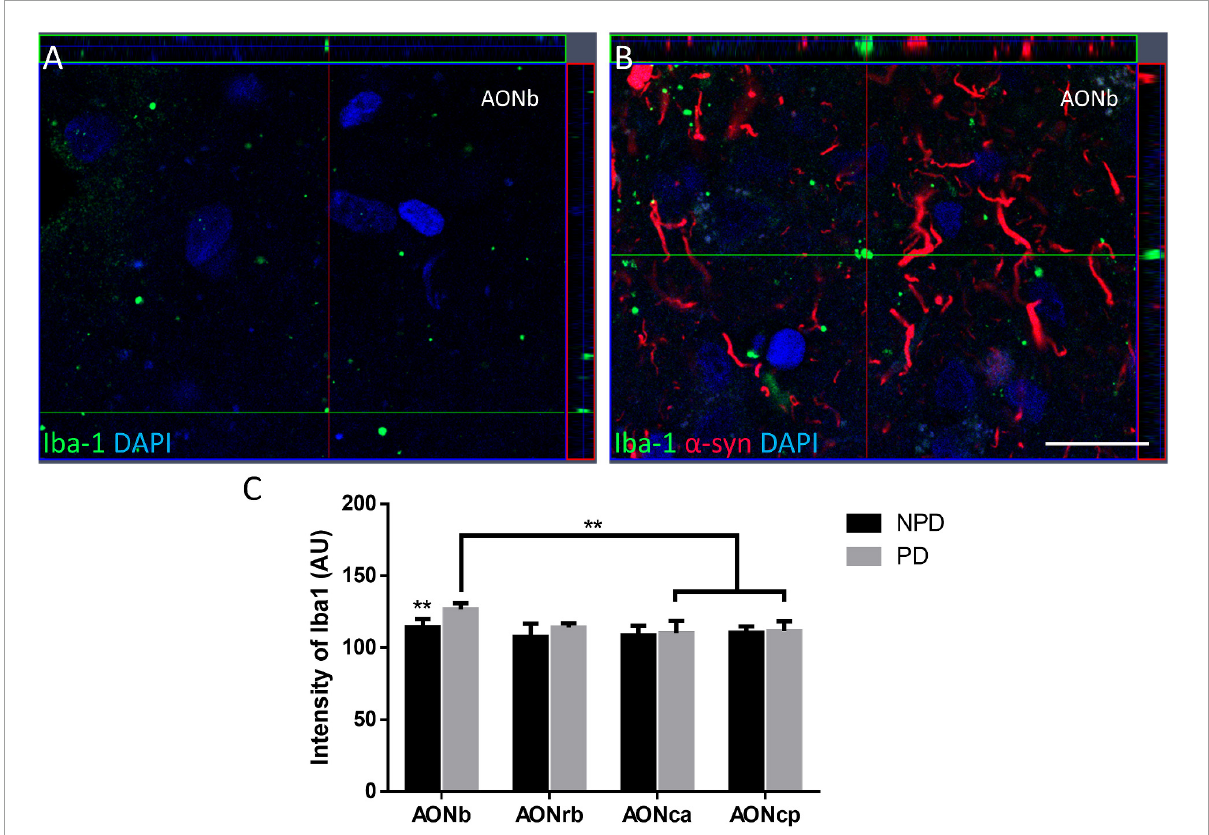
FIGURE3 Iba-1 intensity in the AON. Z-stack confocal images of immunofluorescence of Iba-1 and α -syn in AONb in NPD (A) and PD (B) . The graph depicts the Iba-1 intensity (AU) in AONb, AONrb, AONca, and AON cp (C) . ** P -value <0.01. Scale bar = 20